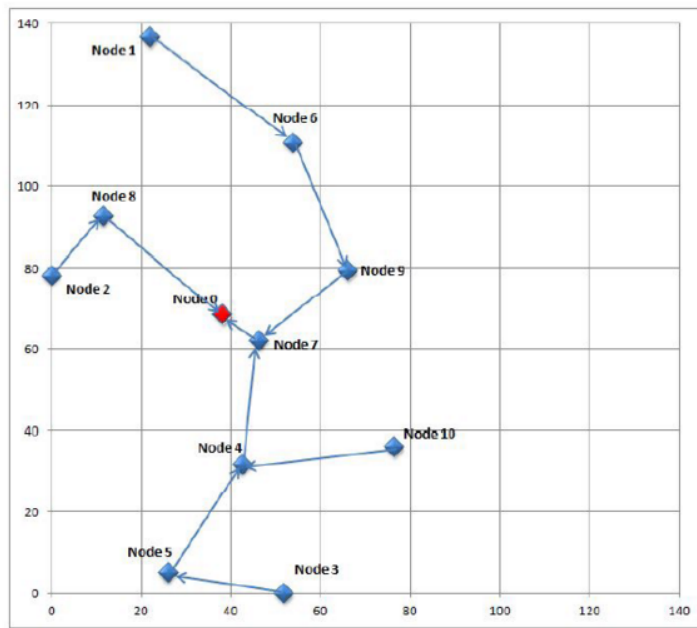
Figure 2. Schema and topology of the simulated WSN. The layout of the sensor nodes ( i.e. , nodes 1-10) reproduces the layout of real sound meters deployed in Barcelona over a 140 m × 140 m terrain. The topology and the base station ( i.e. , node 0) location are setup ad-hoc for the